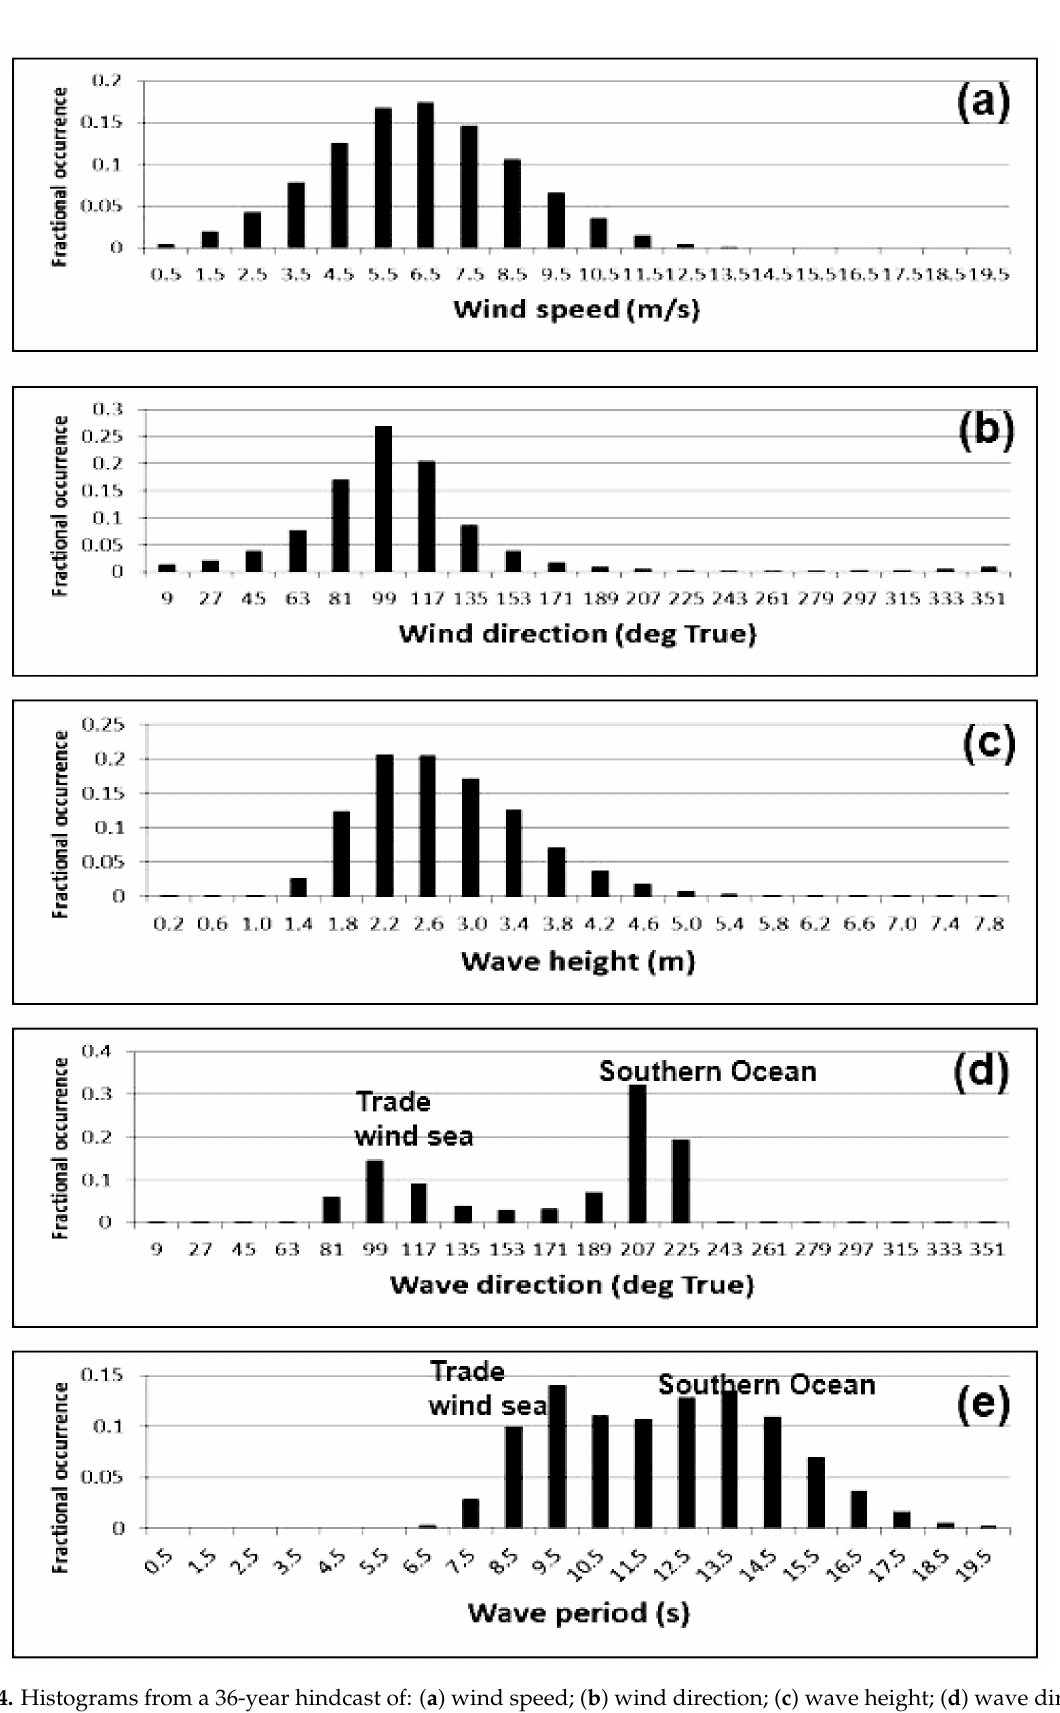
Figure 4. Histograms from a 36-year hindcast of: ( a ) wind speed; ( b ) wind direction; ( c ) wave height; ( d ) wave direction; and ( e ) wave